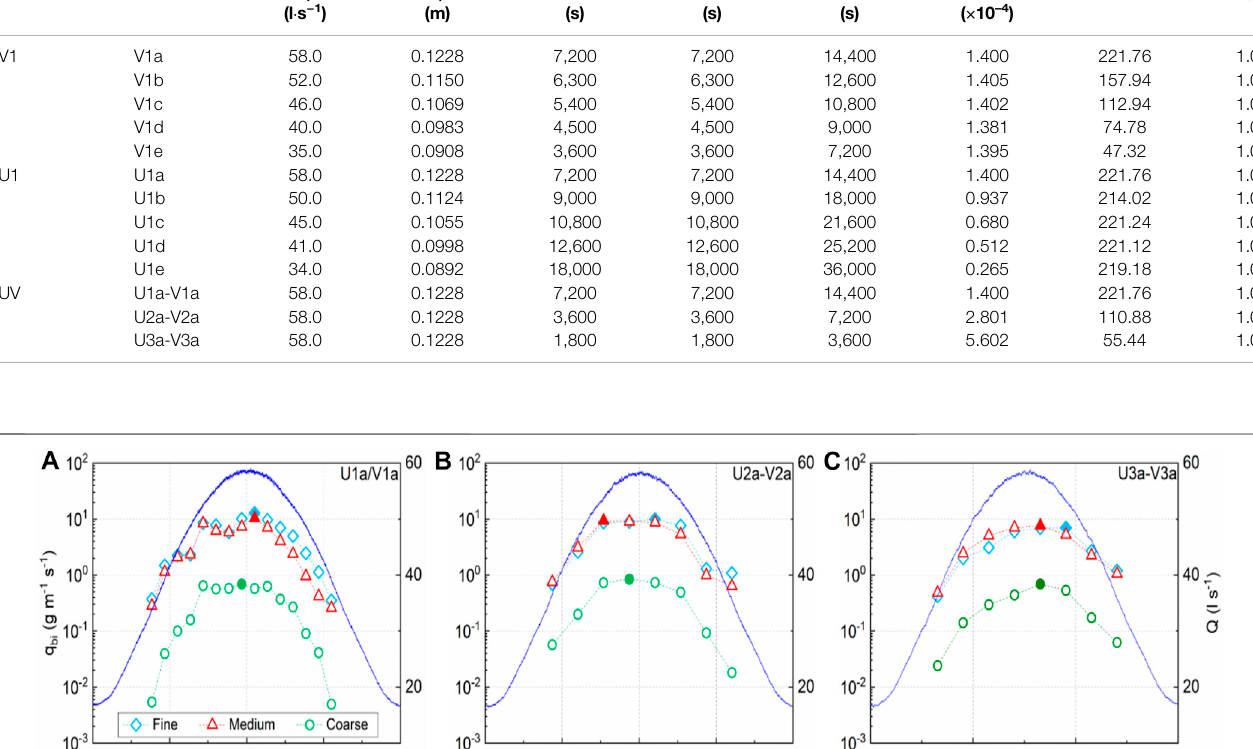
TABLE 1 | Unsteady hydrograph fl ow conditions employed in the present study (Wang et al., 2021). Group